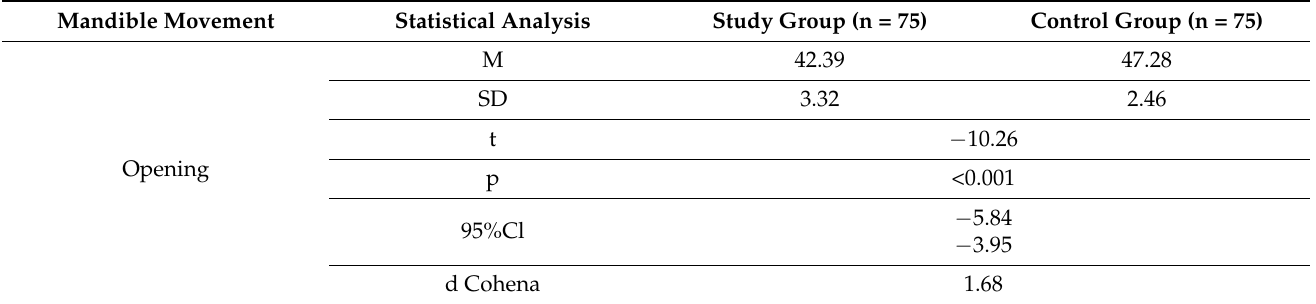
Table 6. Comparison of average ranges of movements between participants from control and study